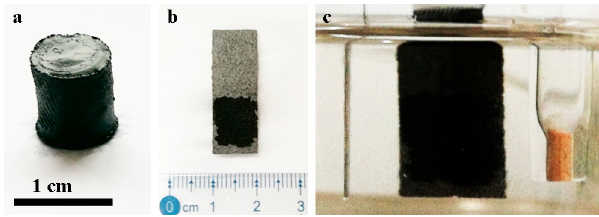
Figure 3. Photographs of GH ( a ), GHE ( b ), and a three-electrode system ( c ) with GHE as the work electrode.